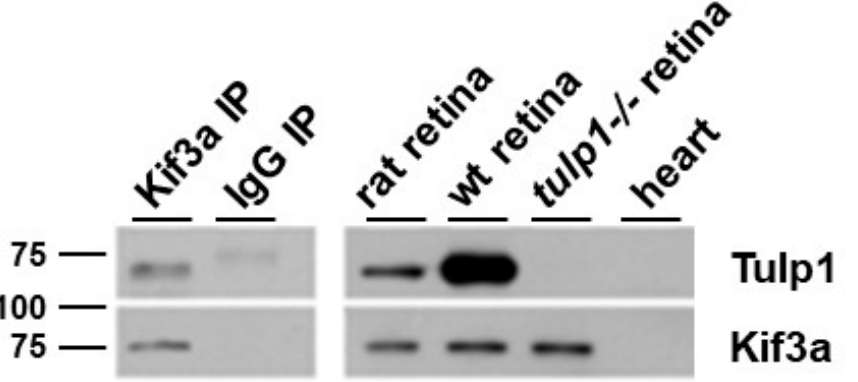
Figure 4. IP of retinal lysate. The top panels show Western blot analysis of the Kif3a IP experimental samples probed with Tulp1 antibodies. In the IP product lane, a band corresponding to Tulp1 is detected. A corresponding band is seen in the rat retinal lysate and wt mouse retinal homogenate but not in the tulp1 − / − retinal lysate, heart lysate or non-specific IgG IP lanes. The bottom panels show Western blot analysis of the Kif3a IP experimental samples probed with Kif3a antibodies. In the IP product, rat retinal lysate, wt mouse retinal lysate and tulp1 − / − retinal lysate lanes, a band corresponding to Kif3a is detected. No bands are seen in the heart or non-specific IgG IP sample